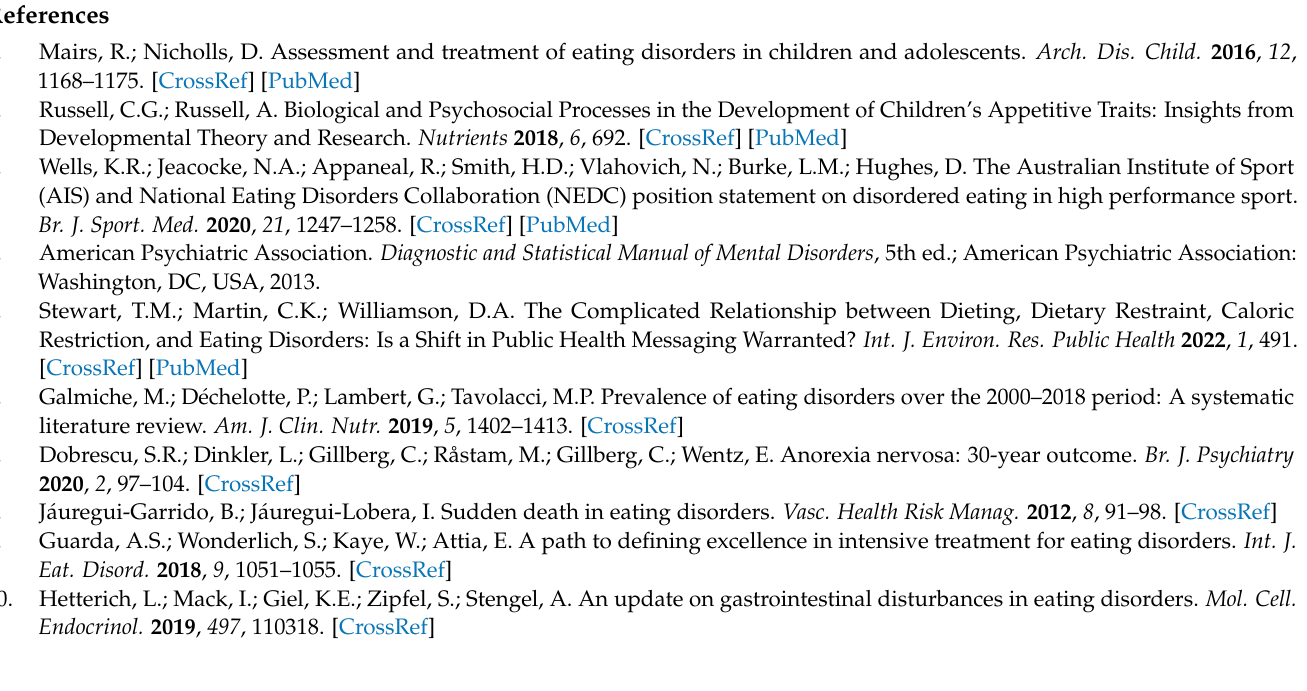
than 10 kg weight. Table S2: Weight loss of 10 kg or more and self-esteem. Table S3: Treatment for eating disorders and